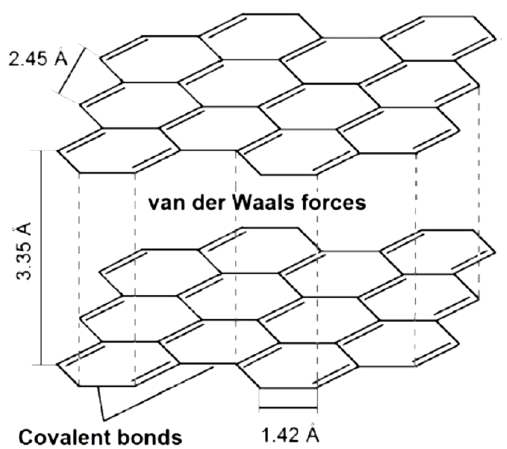
Figure 1. Graphite structure and van der Waals interactions between graphite layers